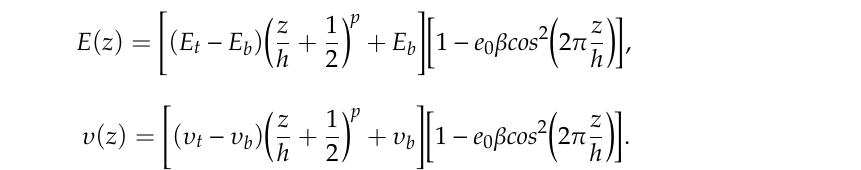
Figure 4. Variation of the normalized Young’s modulus (E(z)) through the thickness for porosity model M2.